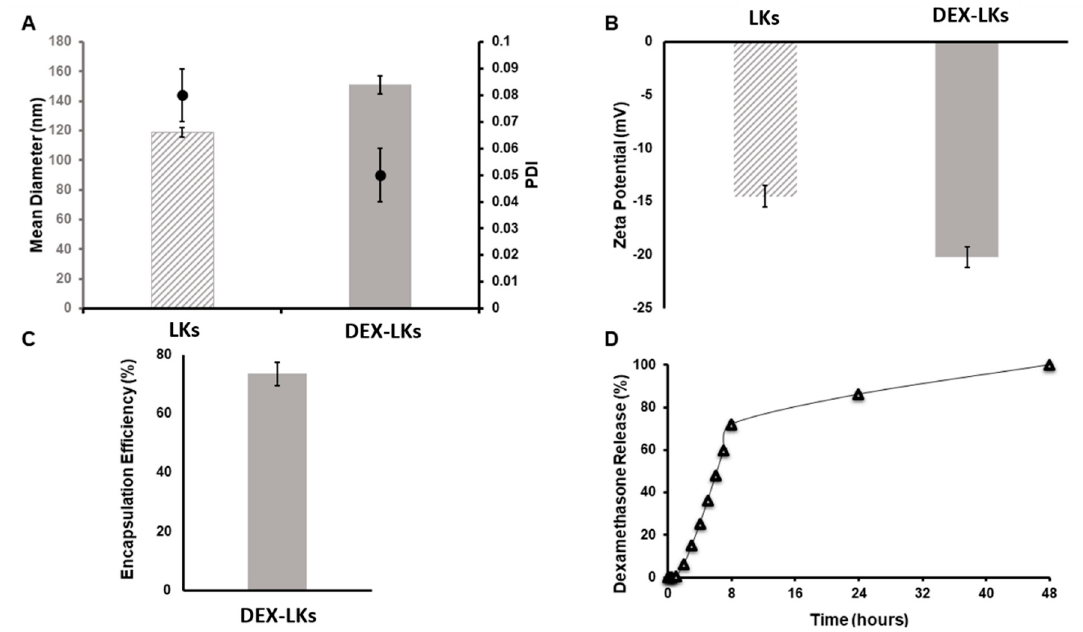
Figure 1. Physical and pharmaceutical characterization of leukosomes and dexamethasone-loaded leukosomes. ( A ) Dynamic light scattering analysis and polydispersity index (PDI) and ( B ) Zeta potential measurements comparing unloaded leukosomes and dexamethasone-loaded leukosomes. Data are presented as mean ± standard deviation. ( C ) Encapsulation e ffi ciency and ( D ) release profile of DEX-Leuko in PBS at 37 ◦